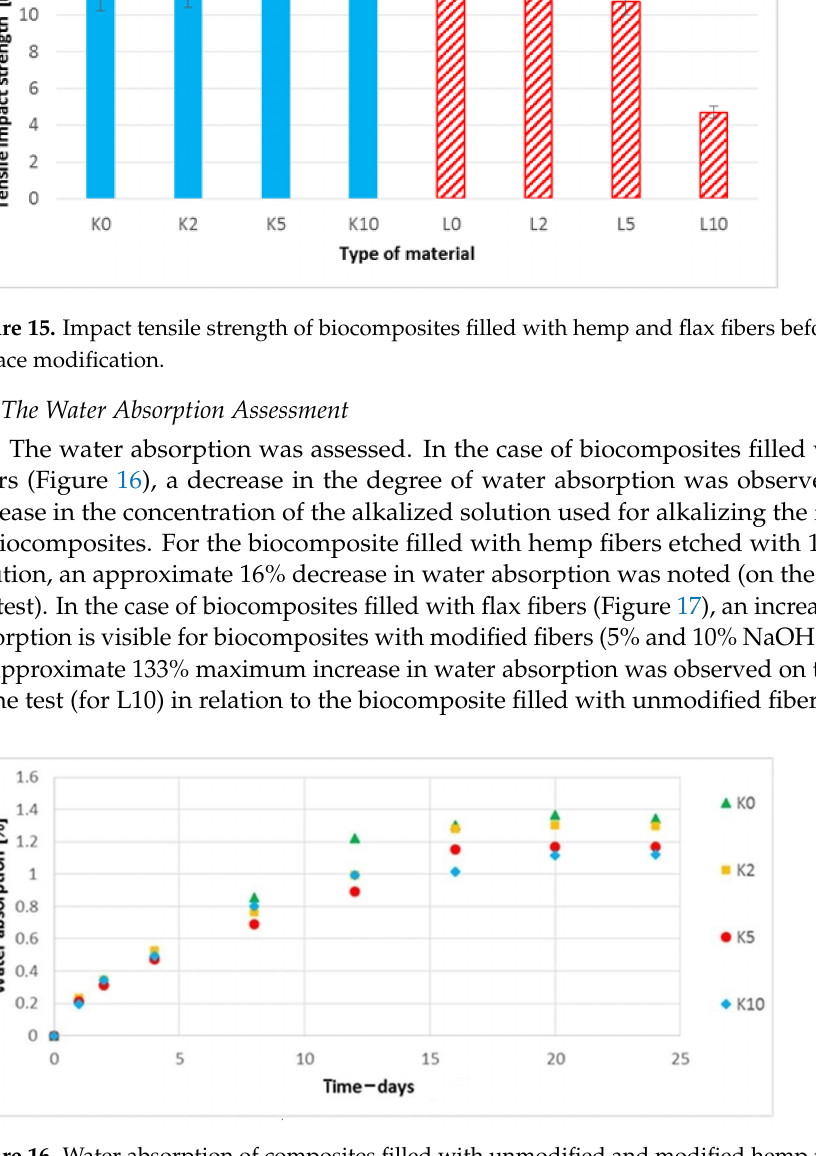
Figure 16. Water absorption of composites filled with unmodified and modified hemp fibers.